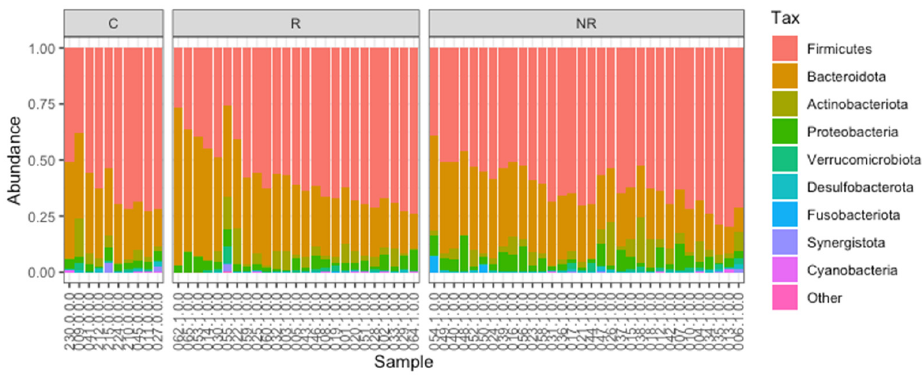
Figure 1. The gut microbiota composition (relative abundance) of the study cohort at the phylum level. Analyzed samples were grouped into C—controls, R—responders, and NR—non-responders.